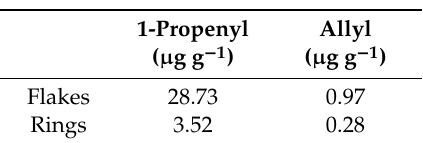
Table 2. Sum of the concentration ( µ g g − 1 ) of the sulfur-containing volatile organic compounds (VOCs) with either the 1-propenyl moiety or the allyl moiety in the onion samples analyzed in the absence of ascorbic